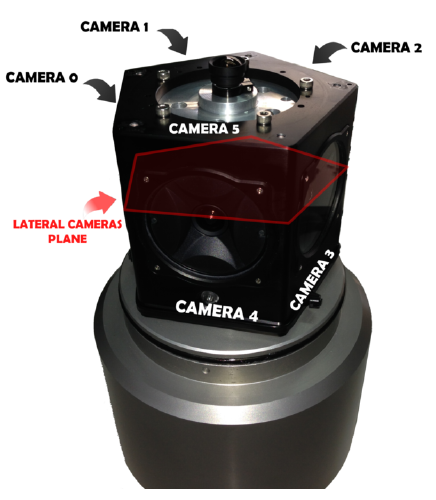
Figure 3. Arrangement of the cameras. The red overlay indicates the plane where the optic centers of the five lateral cameras are located (identified as Camera 0 to Camera 4). The last camera (Camera 5) has its optical axis approximately perpendicular to this